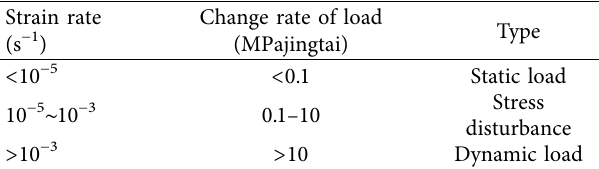
Table 6: Relationship between load and strain rate. Strain